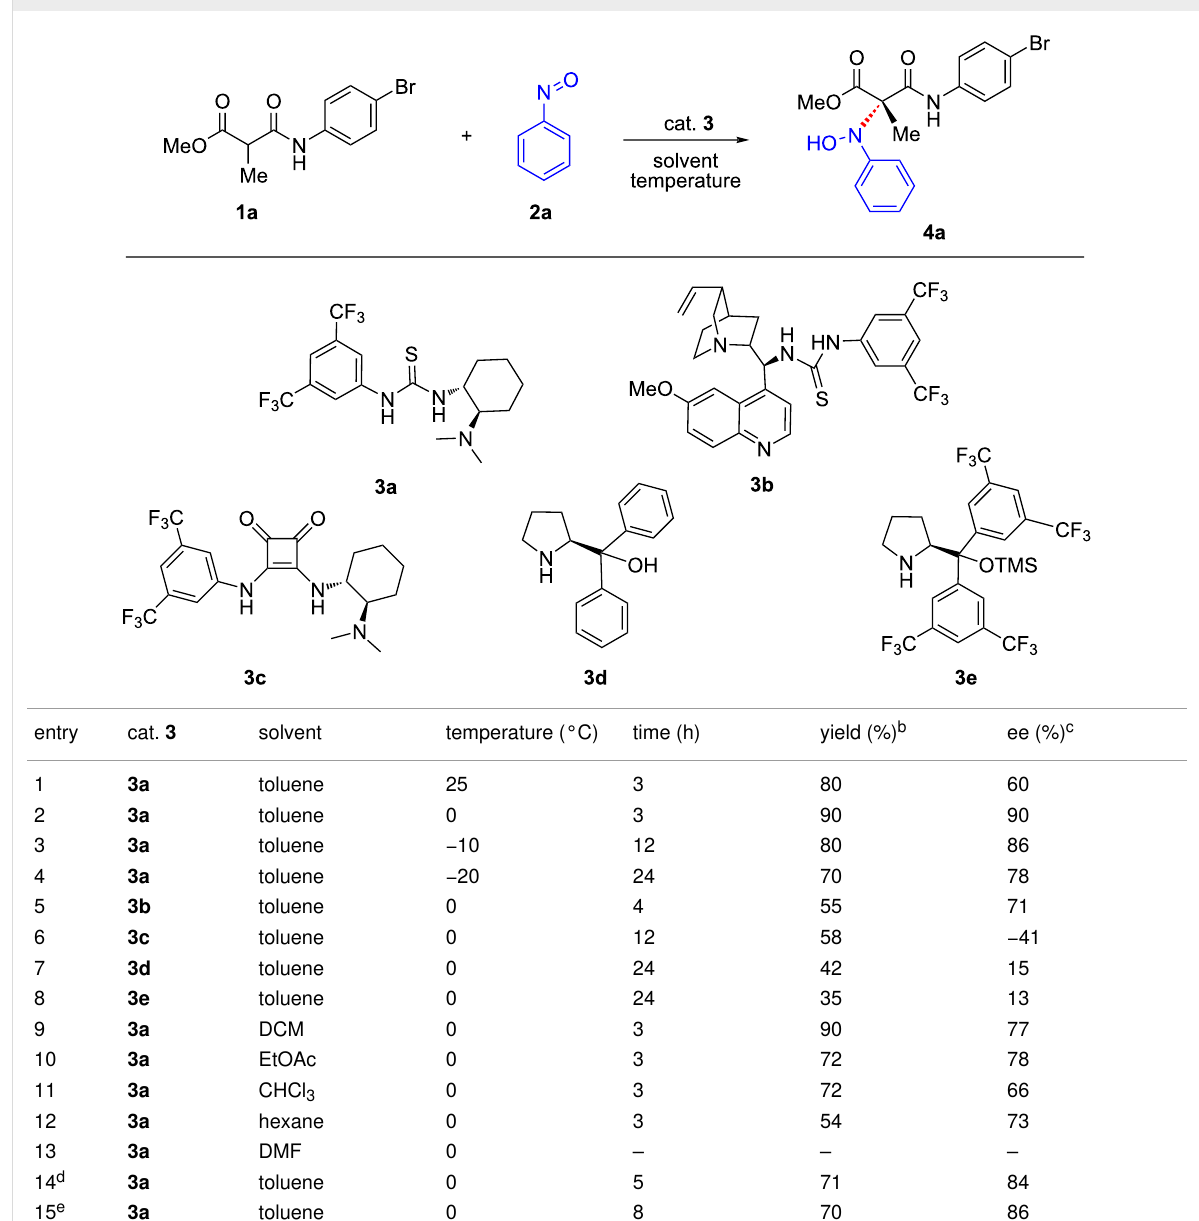
Table 1: Optimization of the reaction conditions.